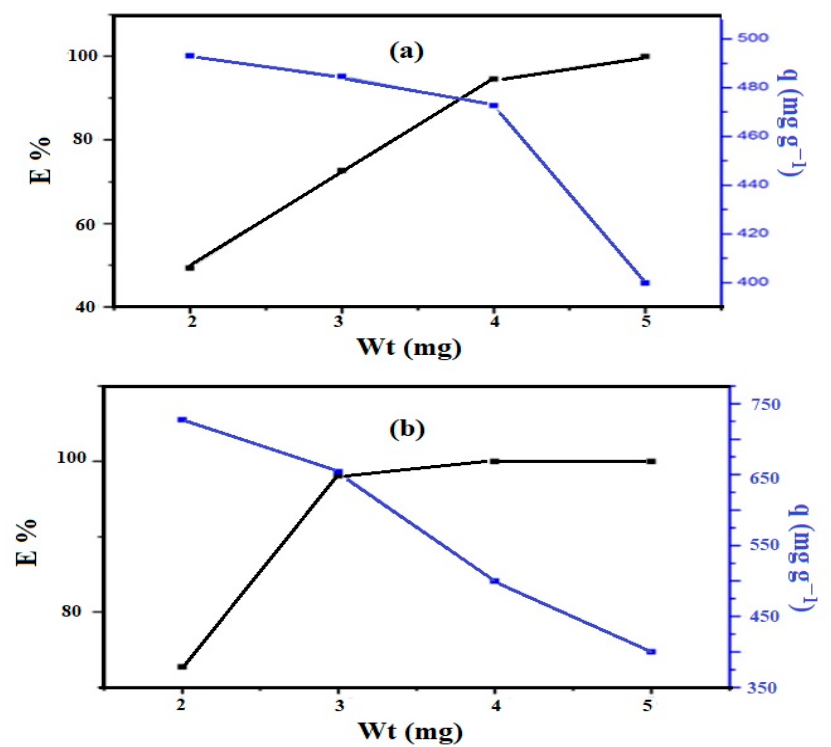
Figure 11. Removal efficiency and adsorption capacity against weight (mg) of ( a ) Si-IL and ( b ) Fe 3 O 4 -Si-IL (at constant room temperature using 20 mL of 100 mg L − 1 of Congo red (CR)).